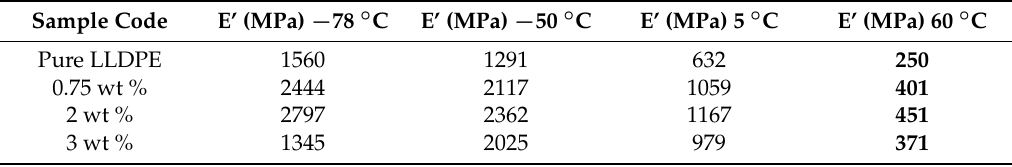
Table 1. Storage modulus, E’, of neat LLDPE and its composites at different temperatures.